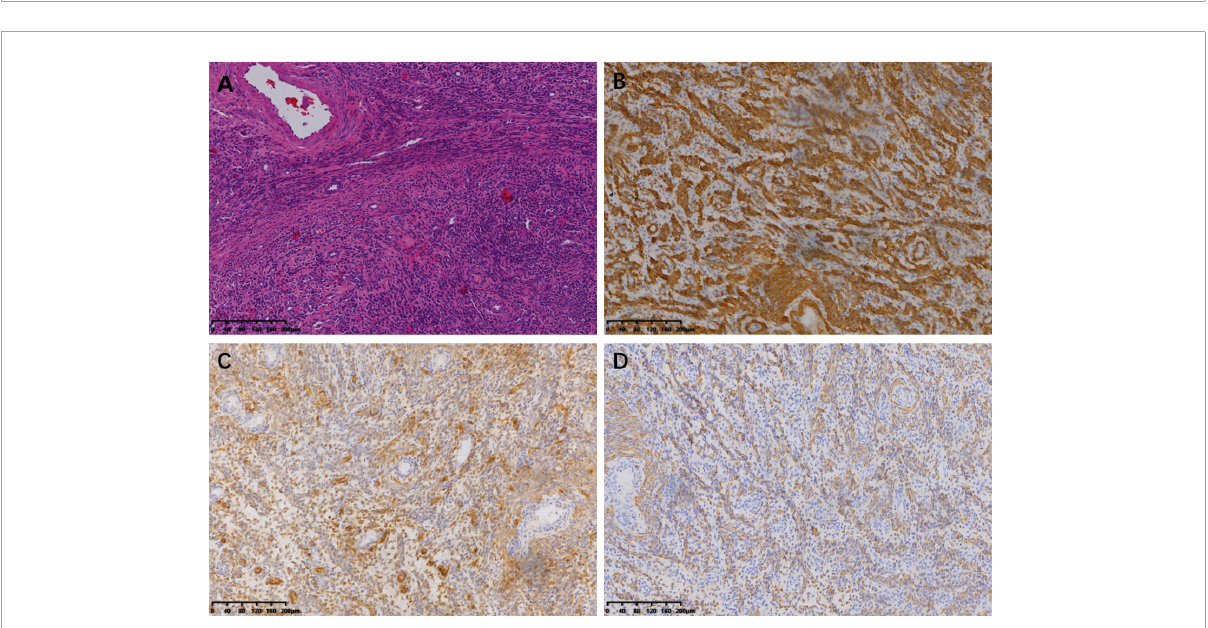
FIGURE7 Microscopic examination of uterine lesion (magnification, × 100). (A) HE staining of the tumor cells. Immunohistochemical staining for SMA (B) , CD10 (C) , and Desmin (D)